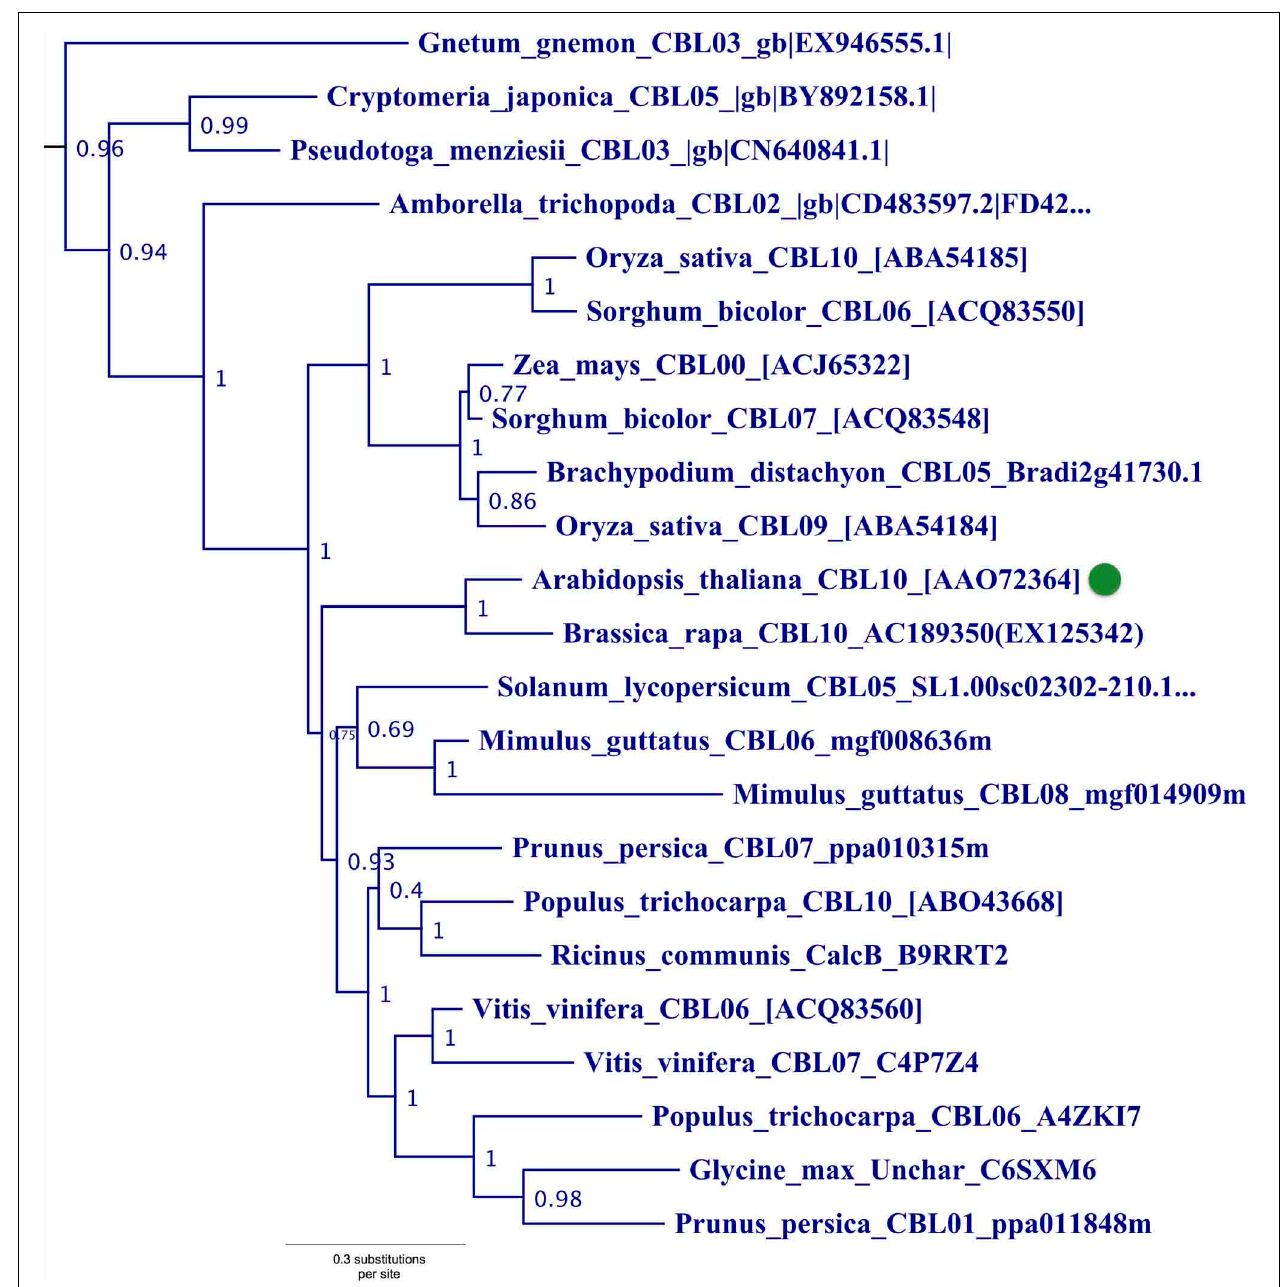
FIGURE 5 | Close-up of Type III CBL clade from ML tree shown in Figure 2. Confidence scores (aLRT) are shown for each clade. Arabidopsis CBL10 (green dot) and orthologs in angiosperms and gymnosperms that share the presence of a single N-terminal transmembrane helix (see